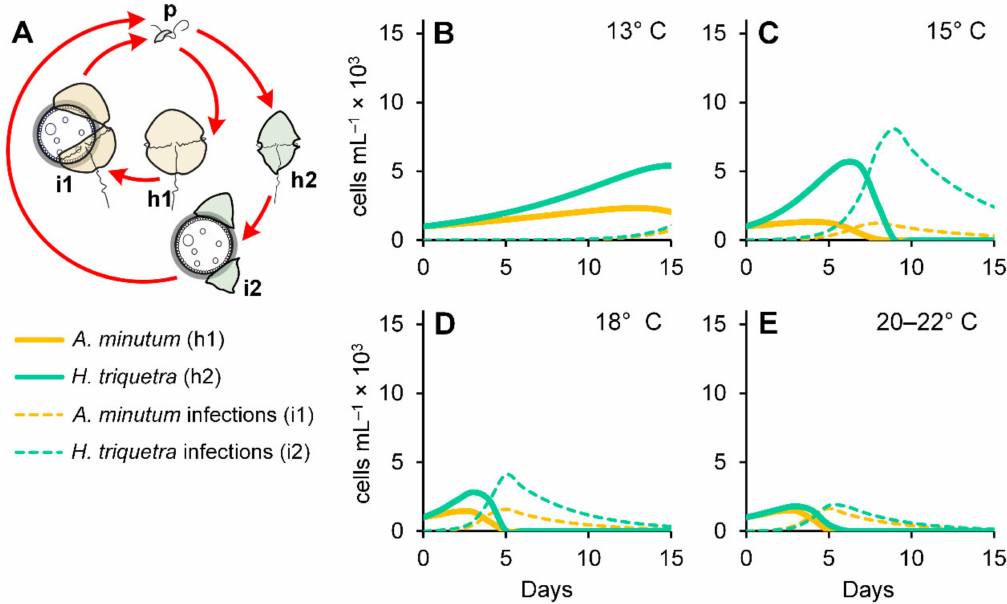
Figure 5. Conceptual model ( A ) used for numerical simulations of Parvilucifera infections in the dinoflagellates Alexandrium minutum and Heterocapsa triquetra under different temperatures ( B – E ). p = P. rostrata zoospores; h1 = uninfected A. minutum ; h2 = uninfected H. triquetra ; i1 = A . minutum infections; i2 = H. triquetra